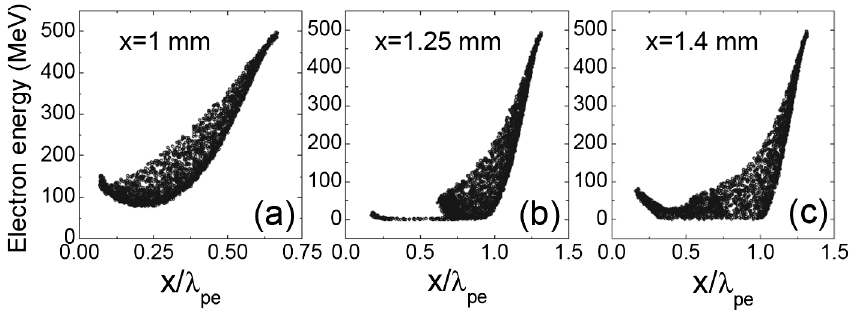
FIG. 2. Electron energy distribution during collective deceleration in nonstructured plasma. Energies are given versus longitudinal position ( x in units of plasma wavelength) at different propagating distances: (a) x ¼ 1 mm , (b) x ¼ 1 : 25 mm , and (c) x ¼ 1 : 4 mm . The plasma density is n e ¼ 2 n b (cid:4) 4 : 4 (cid:3) 10 19 cm (cid:1) 3 , and the initial energy of bunch electrons is 500